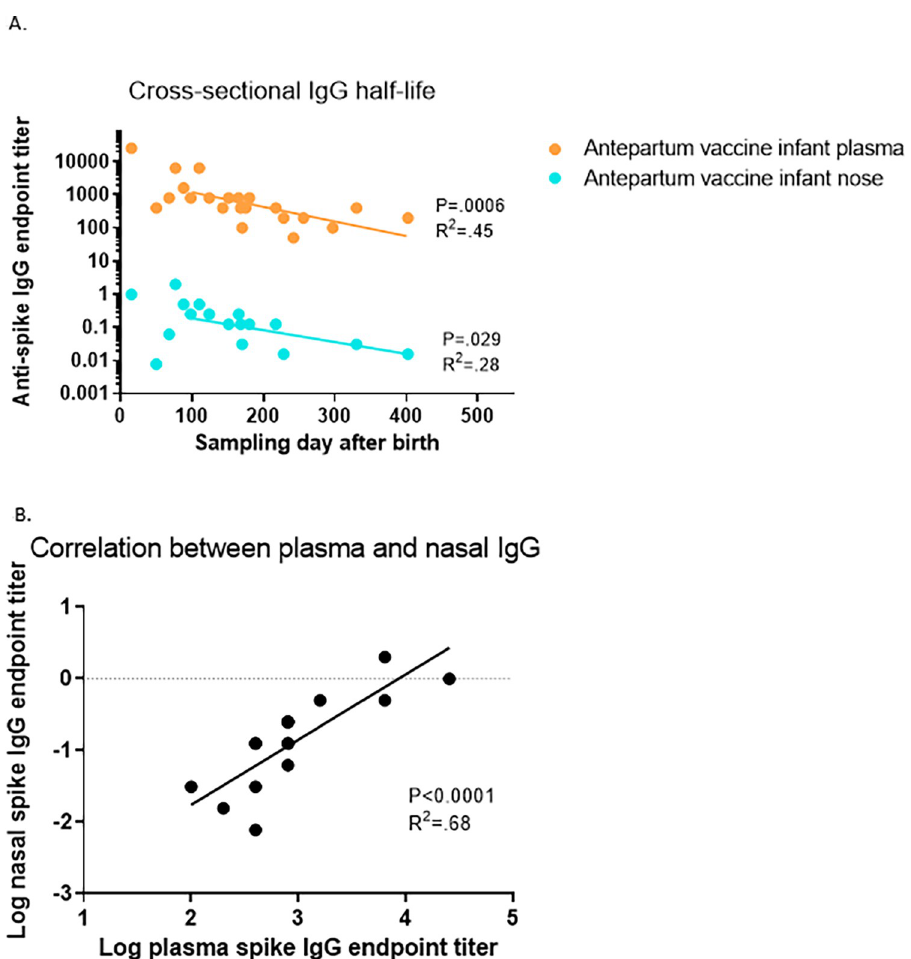
Fig 4. Half-life of maternal IgG in infants and correlation between SARS-CoV-2 spike antibodies nasal and plasma anti-spike IgG. A) Cross-sectional anti-spike IgG from antepartum infant plasma and nasal samples. Using linear regression, cross-sectional plasma IgG t1/2 = 56.9 days; cross-sectional nasal IgG t1/2 = 83.6 days. B) Correlation between plasma and nasal anti-spike IgG endpoint titers. P < 0.0001; R 2 = 0.68. Nasal anti-spike endpoint titers provided as a ratio between nasal IgG endpoint titer/total nasal IgG endpoint